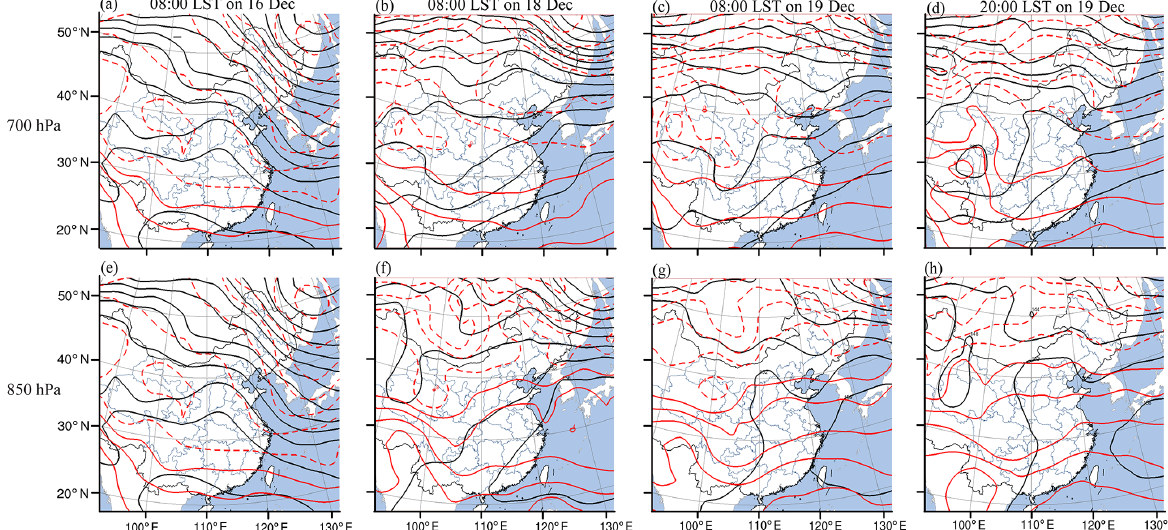
Figure 3. Weather maps. (a) 08:00LST on 16 December at 700hPa; (b) 08:00LST on 18 December at 700hPa; (c) 08:00LST on 19 De- cember at 700hPa; (d) 20:00LST on 19 December at 700hPa; (e) 08:00LST on 16 December at 850hPa; (f) 08:00LST on 18 December at 850hPa; (g) 08:00LST on 19 December at 850hPa; (h) 20:00LST on 19 December at 850hPa.